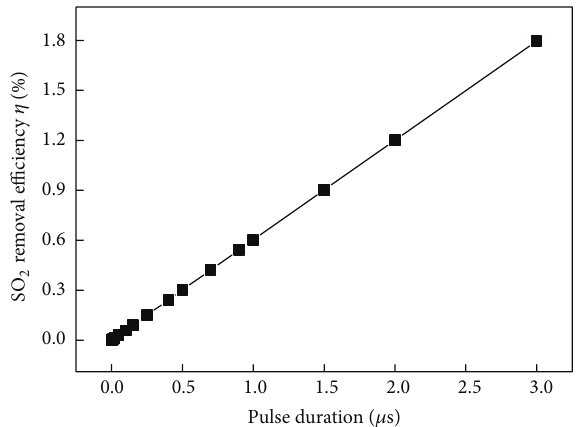
Figure 6: Relationship between SO 2 removal efficiency and the discharge pulse